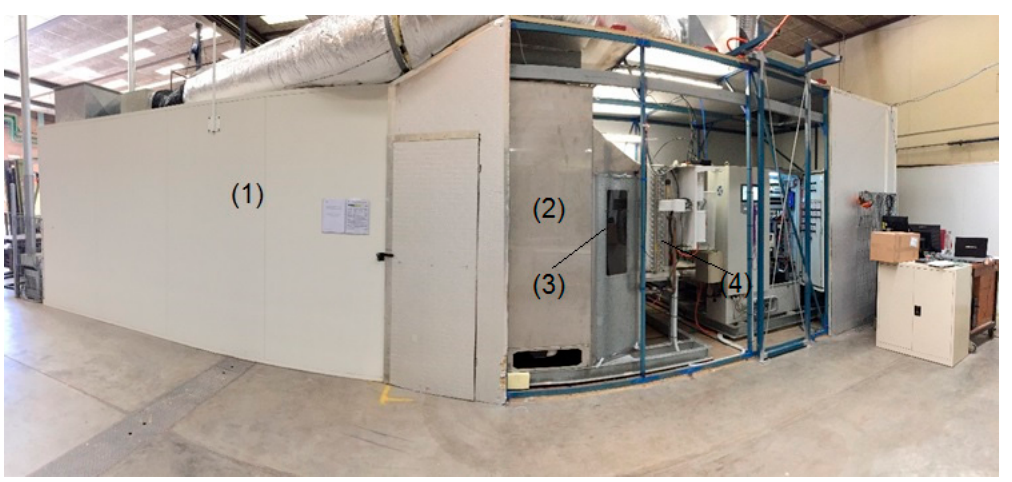
Figure 5. UniSA Test Chamber: (1) Prechamber, (2) Main Chamber, (3) DPC, (4) Gas Cooler (photo credit: BHI-UniSA).